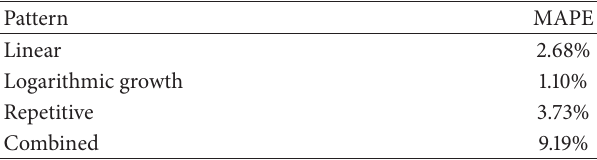
Table 4: The MAPE values of simulation